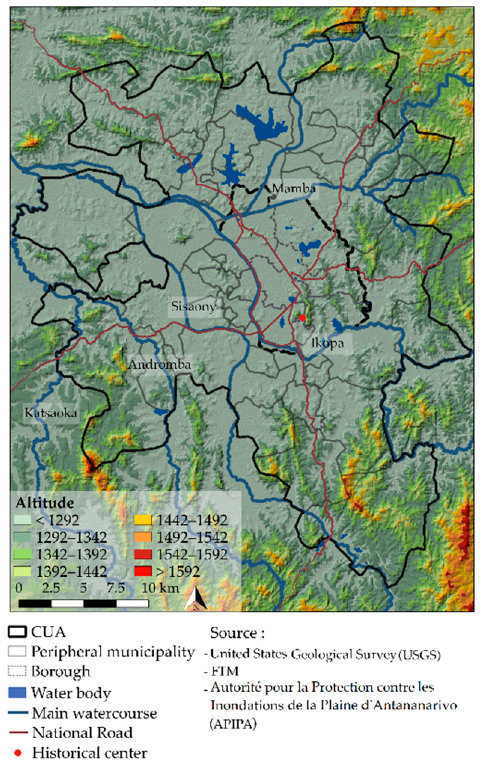
Figure 2. Relief of study area.